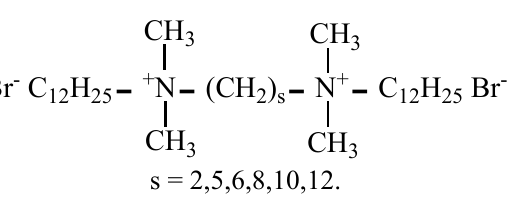
Figure 4. Dimeric